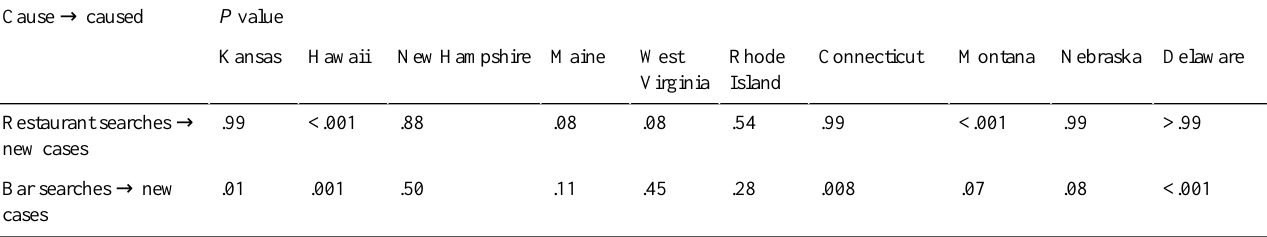
Table 2. P values of the Granger causality tests on daily new cases of COVID-19 for the 10 US states and territories with the fewest daily new cases